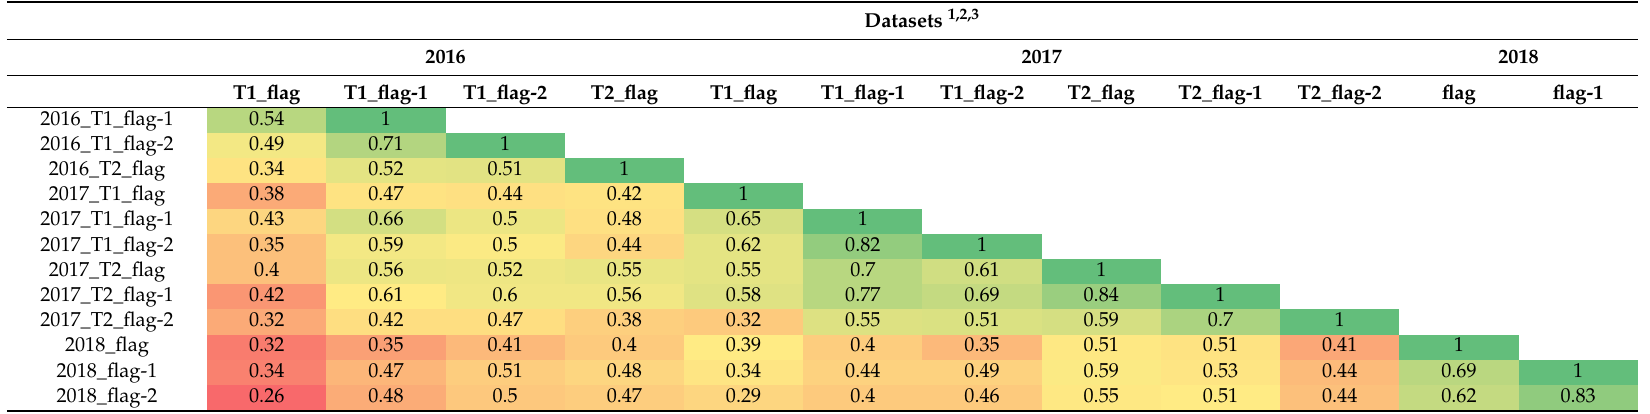
Table 3. Pearson correlation coe ffi cients (r) for septoria tritici blotch (STB) in the field under natural STB infection for all datasets across three field seasons. Best